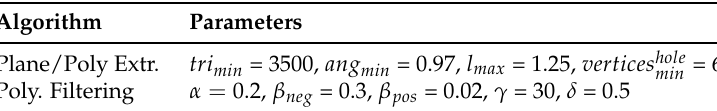
Table 4. Polylidar3D Parameters for